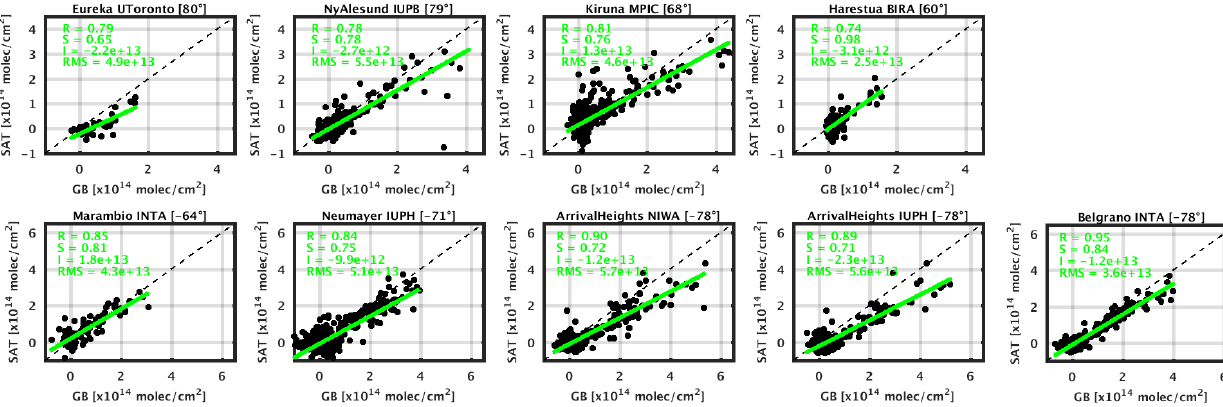
Figure 12. Scatter plot of GOME-2B OClO slant column data co-located with ground-based measurements at each